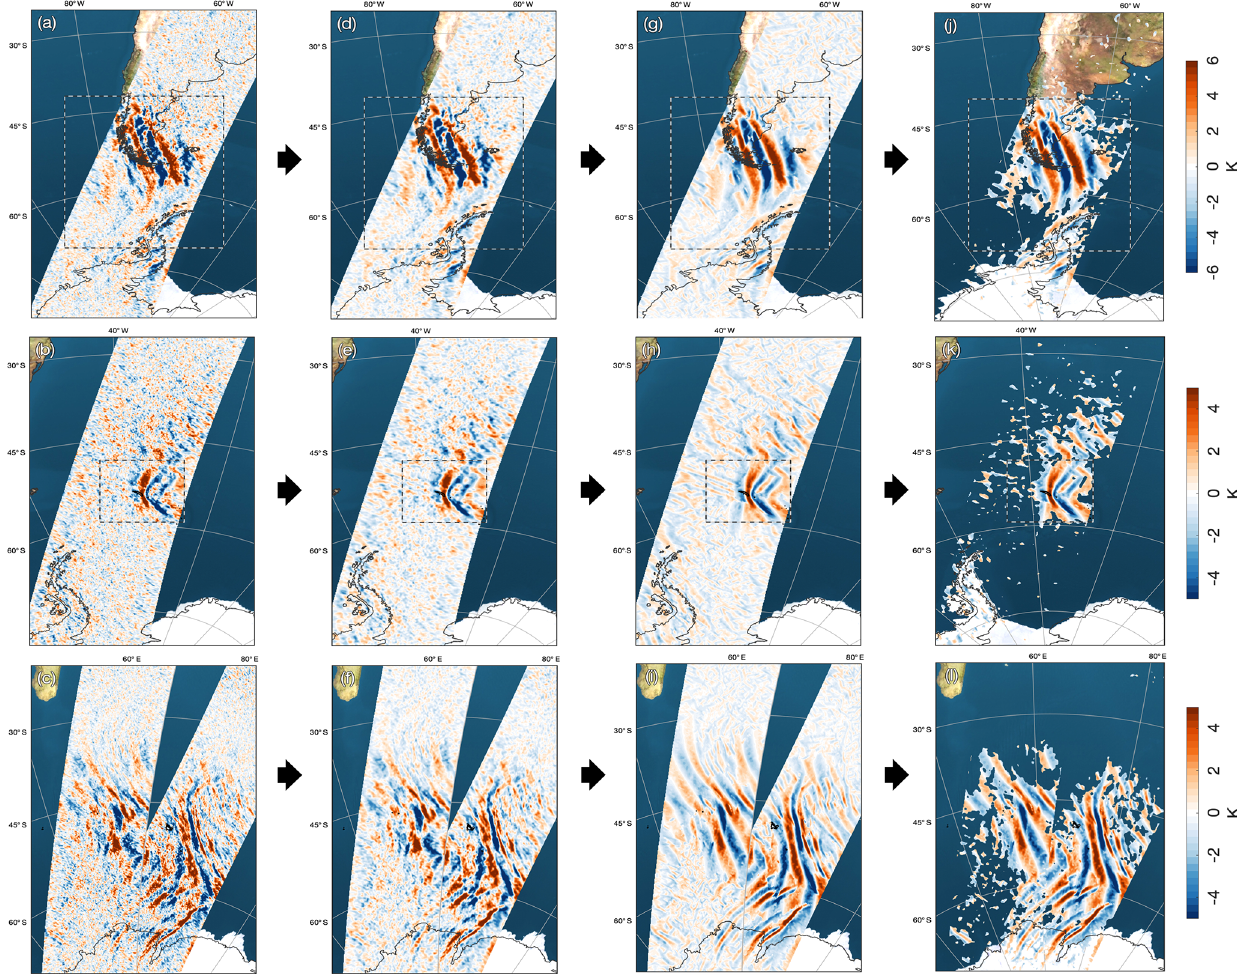
Figure B2. As Fig. 1, but showing our step-by-step approach to mitigating the effect of AIRS retrieval noise in our 3DST gravity wave measurements. The first column (a–c) shows the original, detrended AIRS measurements at z = 40km. The second column (d–f) shows the effect of the 3 × 3 horizontal boxcar smoothing. The third column (g–i) shows the real part of the complex 3DST output, which produces a reconstruction of the input data “as the 3DST sees it”, using our tuning settings to ignore small-scale noise features with horizontal wavelengths λ H < 40km. Finally, the fourth column (j–l) is as the third column, except that regions where the absolute 3DST-measured wave amplitude is less than 1.5K have been removed. It is only these remaining regions that are considered in our momentum flux, wavelength, intermittency and wavevector direction results in the main body of the